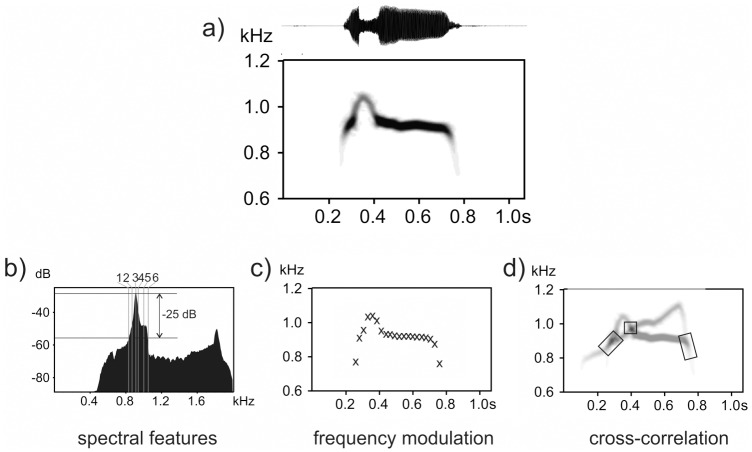
Illustration of little owl call and three methods used for the call description.Example the single territorial call of the little owl male (spectrogram and oscilogram, a), and an illustration of the three call description methods: b) description of call spectral features (1 = minF, 2 = q25, 3 = dF, 4 = q50, 5 = q75, 6 = maxF); c) description of call frequency modulation; and d) cross-correlation of calls (rectangles indicate cross-correlating segments between two displayed calls). Spectrogram settings: FFT-length = 512, window type = Flat Top, window overlap = 93.75%.